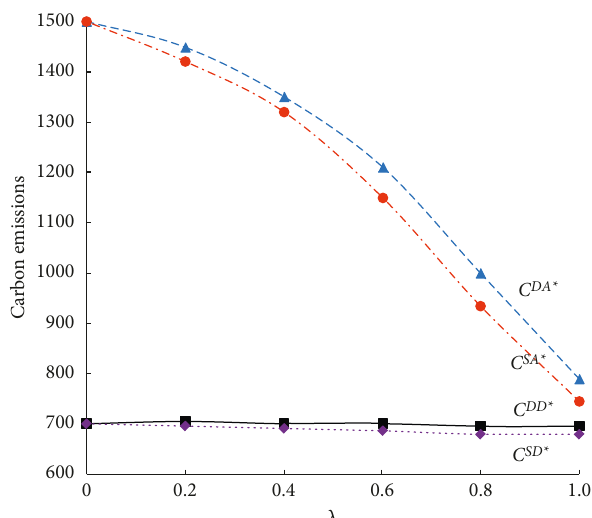
Figure 11: The impact of λ on carbon